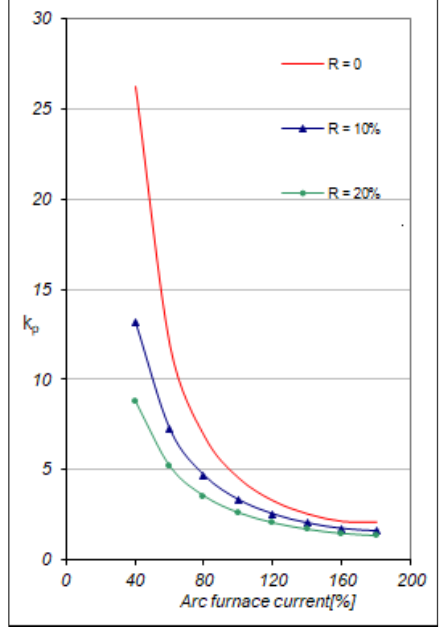
Figure 6. Changes in the k p factor of the power–voltage characteristics for various arc supply resistances, as a function of the current consumed by the arc device.